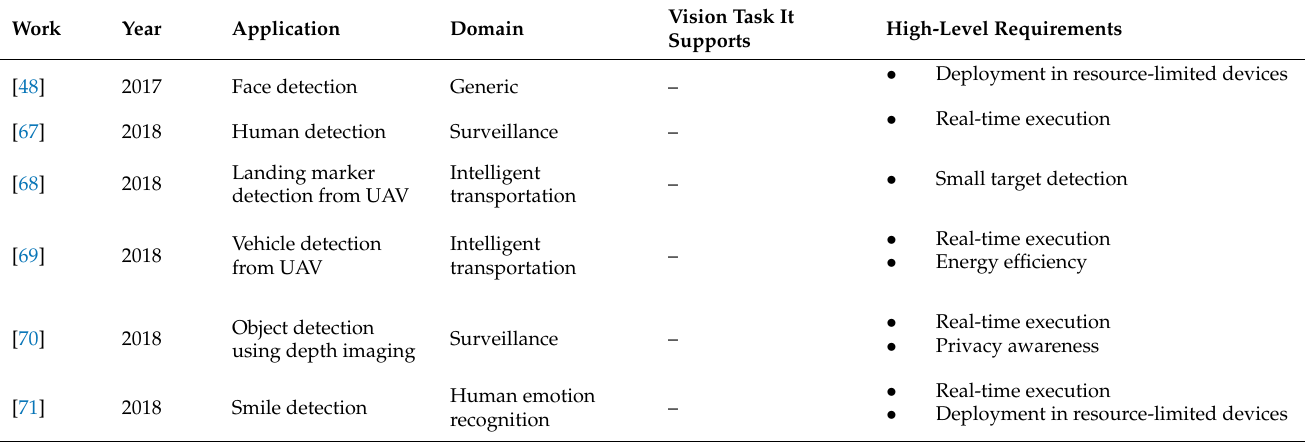
Table 1. Recent research works exploring the use of on-device object detection techniques for building AmI